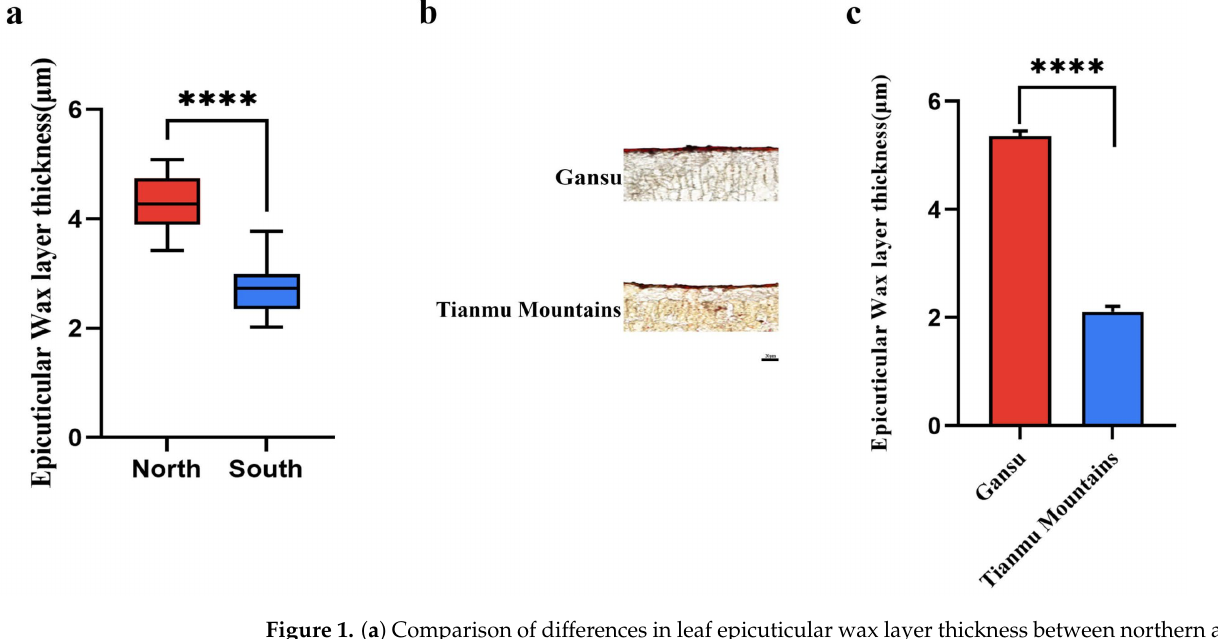
Figure 1. ( a ) Comparison of differences in leaf epicuticular wax layer thickness between northern and southern wild samples. Error bars indicate standard errors. ‘****’ on error bar indicates a significant difference between the two groups at p < 0.0001. ( b ) Characterization of the anatomical structures of Gansu and Tianmu Mountains samples. The length of the scale is 20μm. The complete semi-thin section is shown in Figure S1. ( c ) Leaf epicuticular wax layer thickness analysis of Gansu and Tianmu Mountains samples. Error bars indicate standard errors. ‘****’ on error bar indicates a significant difference between the two groups at p < 0.0001.